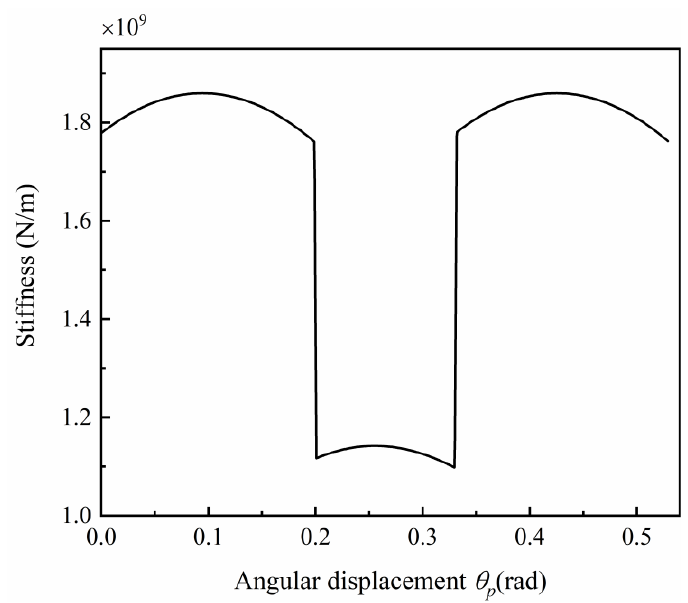
Figure 2. Time-varying mesh stiffness (TVMS) with angular displacement.